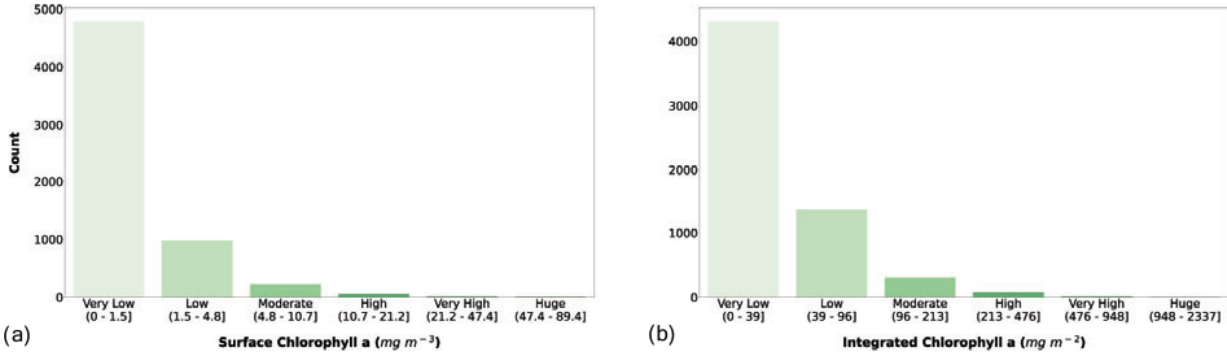
Figure 7. (a) Surface chlorophyll a and (b) depth-integrated chlorophyll a classes. The bar color intensity reflects the magnitude of the class